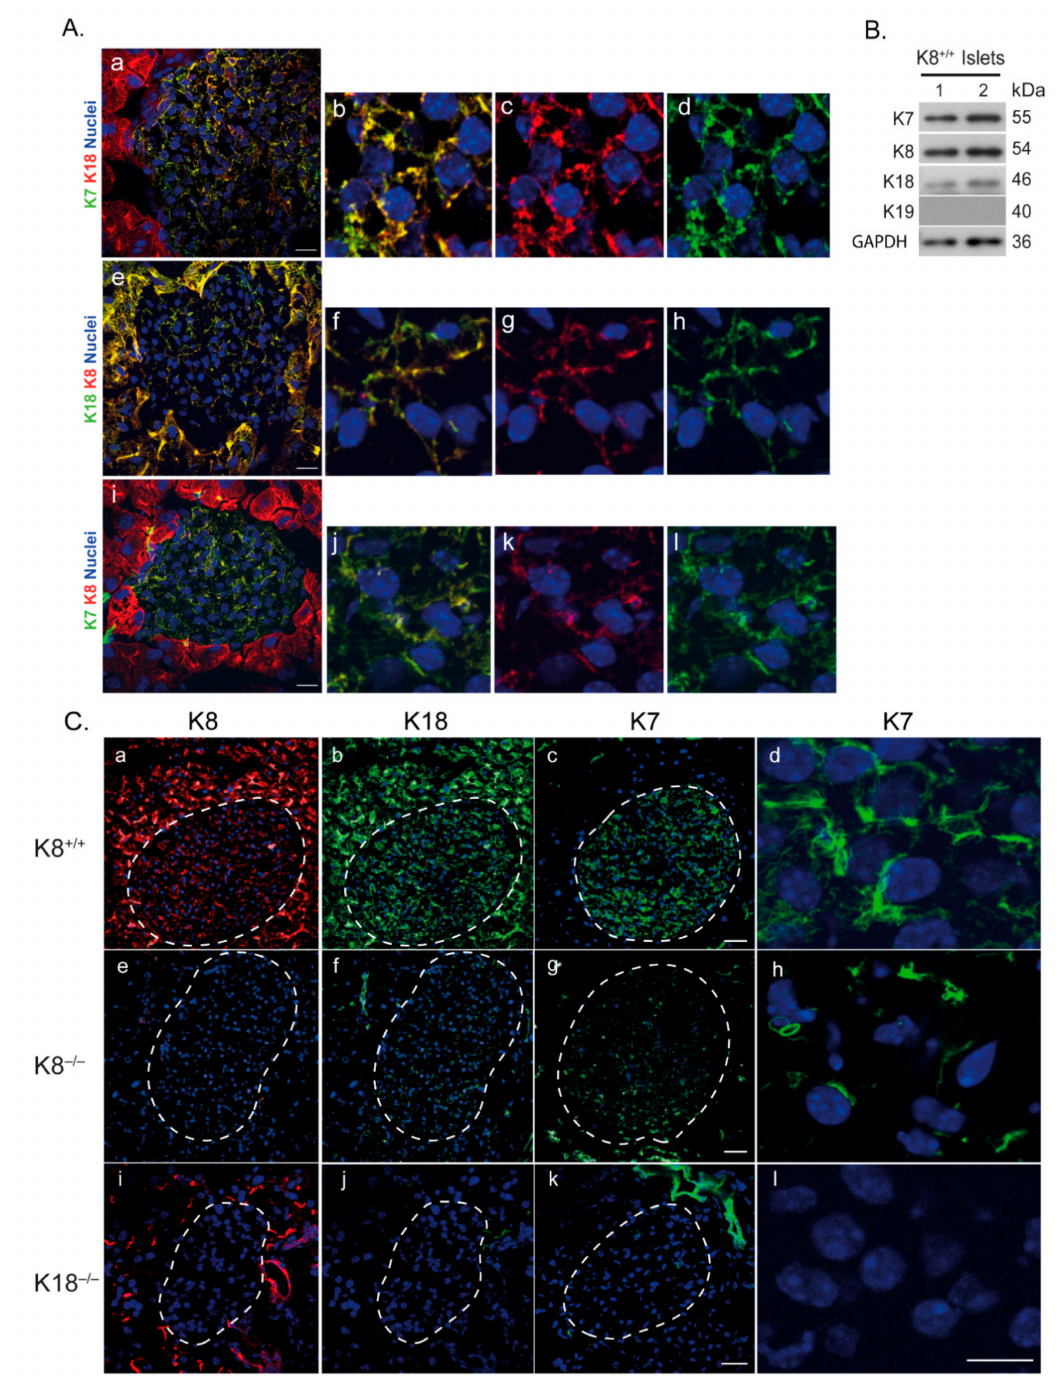
Figure 1. K7 is expressed in pancreatic islets alongside K8 and K18 and its expression is dependent on K18 levels. ( A ) Wild-type K8 +/+ mouse pancreatic tissue sections were immunostained for K7, K8, K18 and nuclei. The merged images of double staining ( a , e , i ) as well as the individual separate images labelling K7, K8 and K18 ( b – d , f – h , j – l , show co-expression of K7/K8 and K18 filaments in islets. Scale bar = 20 µ m. ( B ) Protein lysate from pancreatic islet cells isolated from wild-type K8 +/+ mice (lanes 1–2) were immunoblotted for K7, K8, K18, K19 and GAPDH (loading control). Each lane contains islets isolated from 2 mice. ( C ) Immunostaining of pancreatic sections from K8 +/+ ( a – d ), K8 − / − ( e – h ) and K18 − / − ( i – l ) mice for K8, K18 and K7, showed a reduction in K7 expression in K8 − / − islets ( h ) and total absence of K7 in mice lacking K18 ( l ). Scale bar = 50 µ m (in c , g , k for a – c , e – g , i – k ) and 20 µ m (for d , h , l ). n = 3 mice per